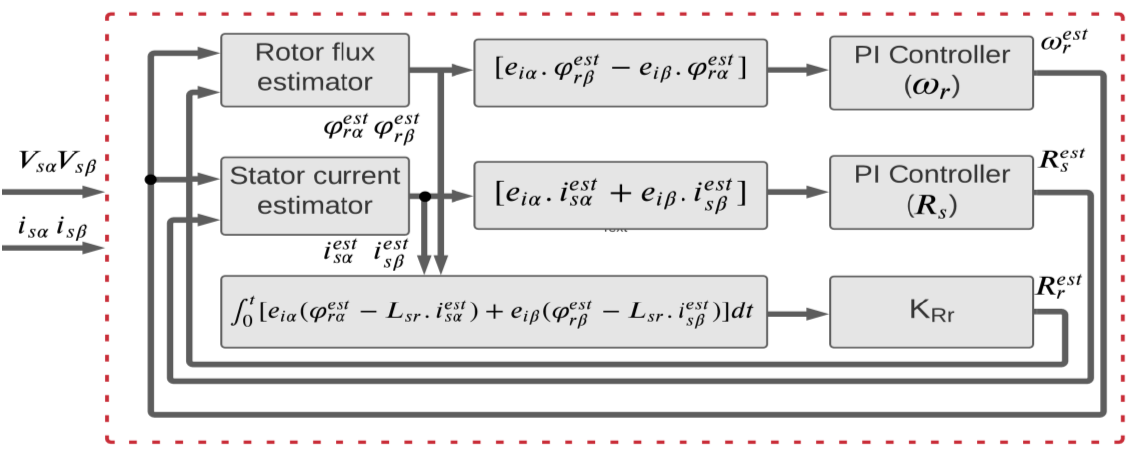
Figure 3. General structure of SC-MRAS estimator.